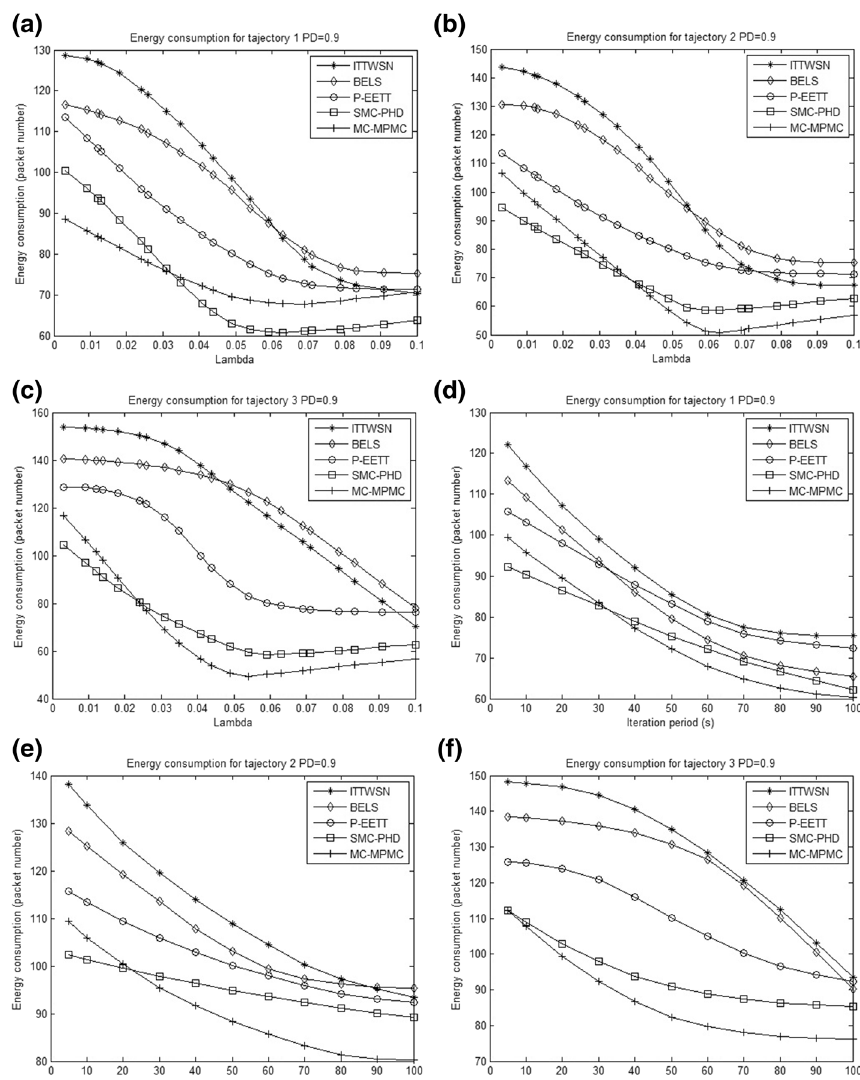
Fig. 10 a – c Tracking energy consumption comparisons related to node density (cid:31) 0 . a Trajectory 1; b Trajectory 2; c Trajectory 3. d – f Tracking energy consumption comparisons related to iteration periods. d Trajectory 1; e Trajectory 2; f Trajectory